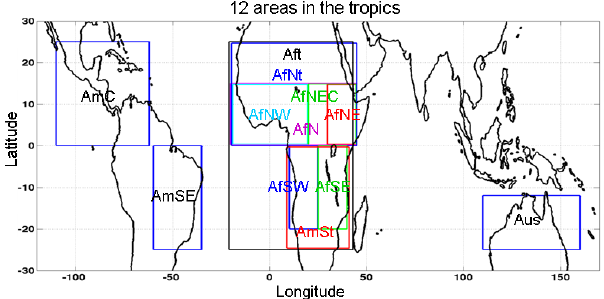
Figure 7. Definition of the studied areas in the tropics. Adapted from Chédin et al. (2008). Only lands are considered. Af, Am and Aus respectively stand for Africa, America and Australia. N, S, E and W respectively stand for north, south, east and west, and t stands for